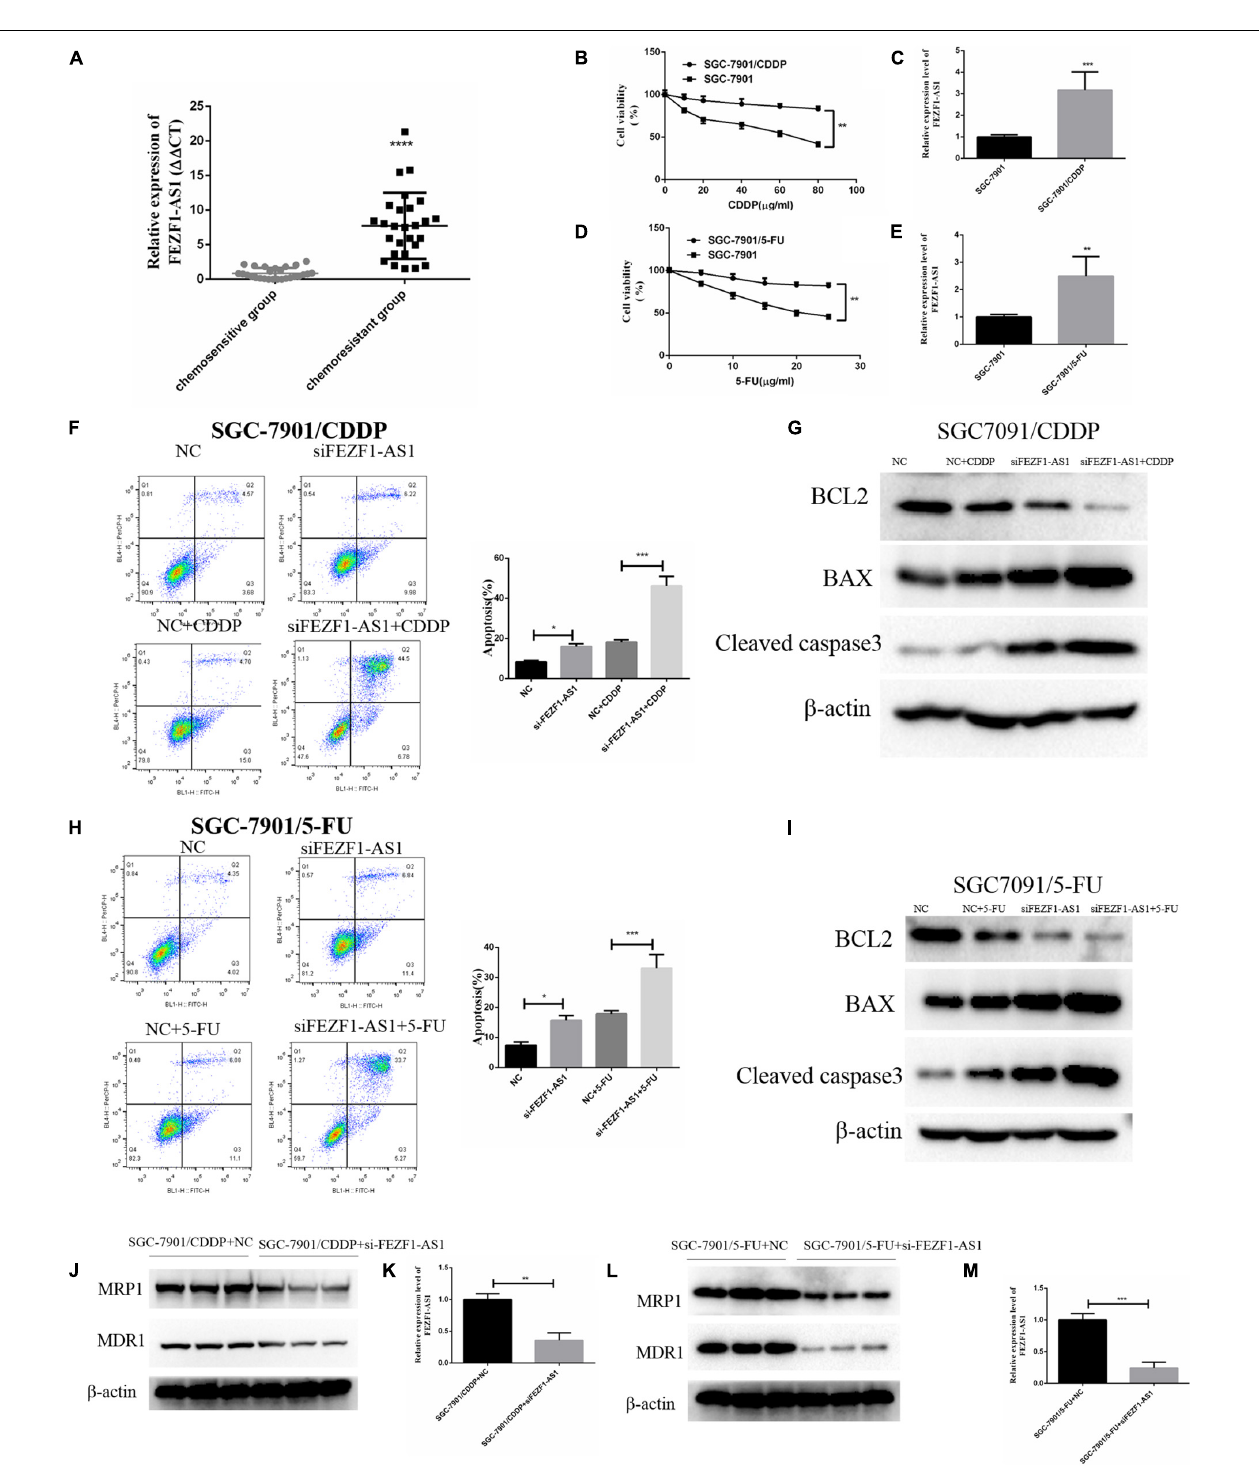
FIGURE 3 | FEZF1-AS1 was upregulated in chemo-resistant GC tissues and knockdown of FEZF1-AS1 improved chemo-sensitivity of GC cells. (A) qRT-PCR on the level of FEZF1-AS1 in 27 pairs of specimens from GC patients with poor response to chemotherapy were 3.5-fold increase compared with patients with good response. (B) CCK8 assay on the viability of SGC-7901 and SGC-7901/CDDP cells treated with 10–80 µ g/ml of CDDP for 24 h. (C) qRT-PCR on the level of FEZF1-AS1 in SGC-7901 and SGC-7901/CDDP cells. (D) CCK8 assay on the viability of SGC-7901 and SGC-7901/5-FU cells treated with 5–25 µ g/ml of 5-FU for 24 h. (E) qRT-PCR on the level of FEZF1-AS1 in SGC-7901 and SGC-7901/5-FU cells. (F) Representative images and quantitation of flow cytometric analysis of apoptotic SGC-7901/CDDP cells with or without the treatment of FEZF1-AS1 siRNA after 24 h incubation with CDDP (40 mg/ml). (G) Western blot